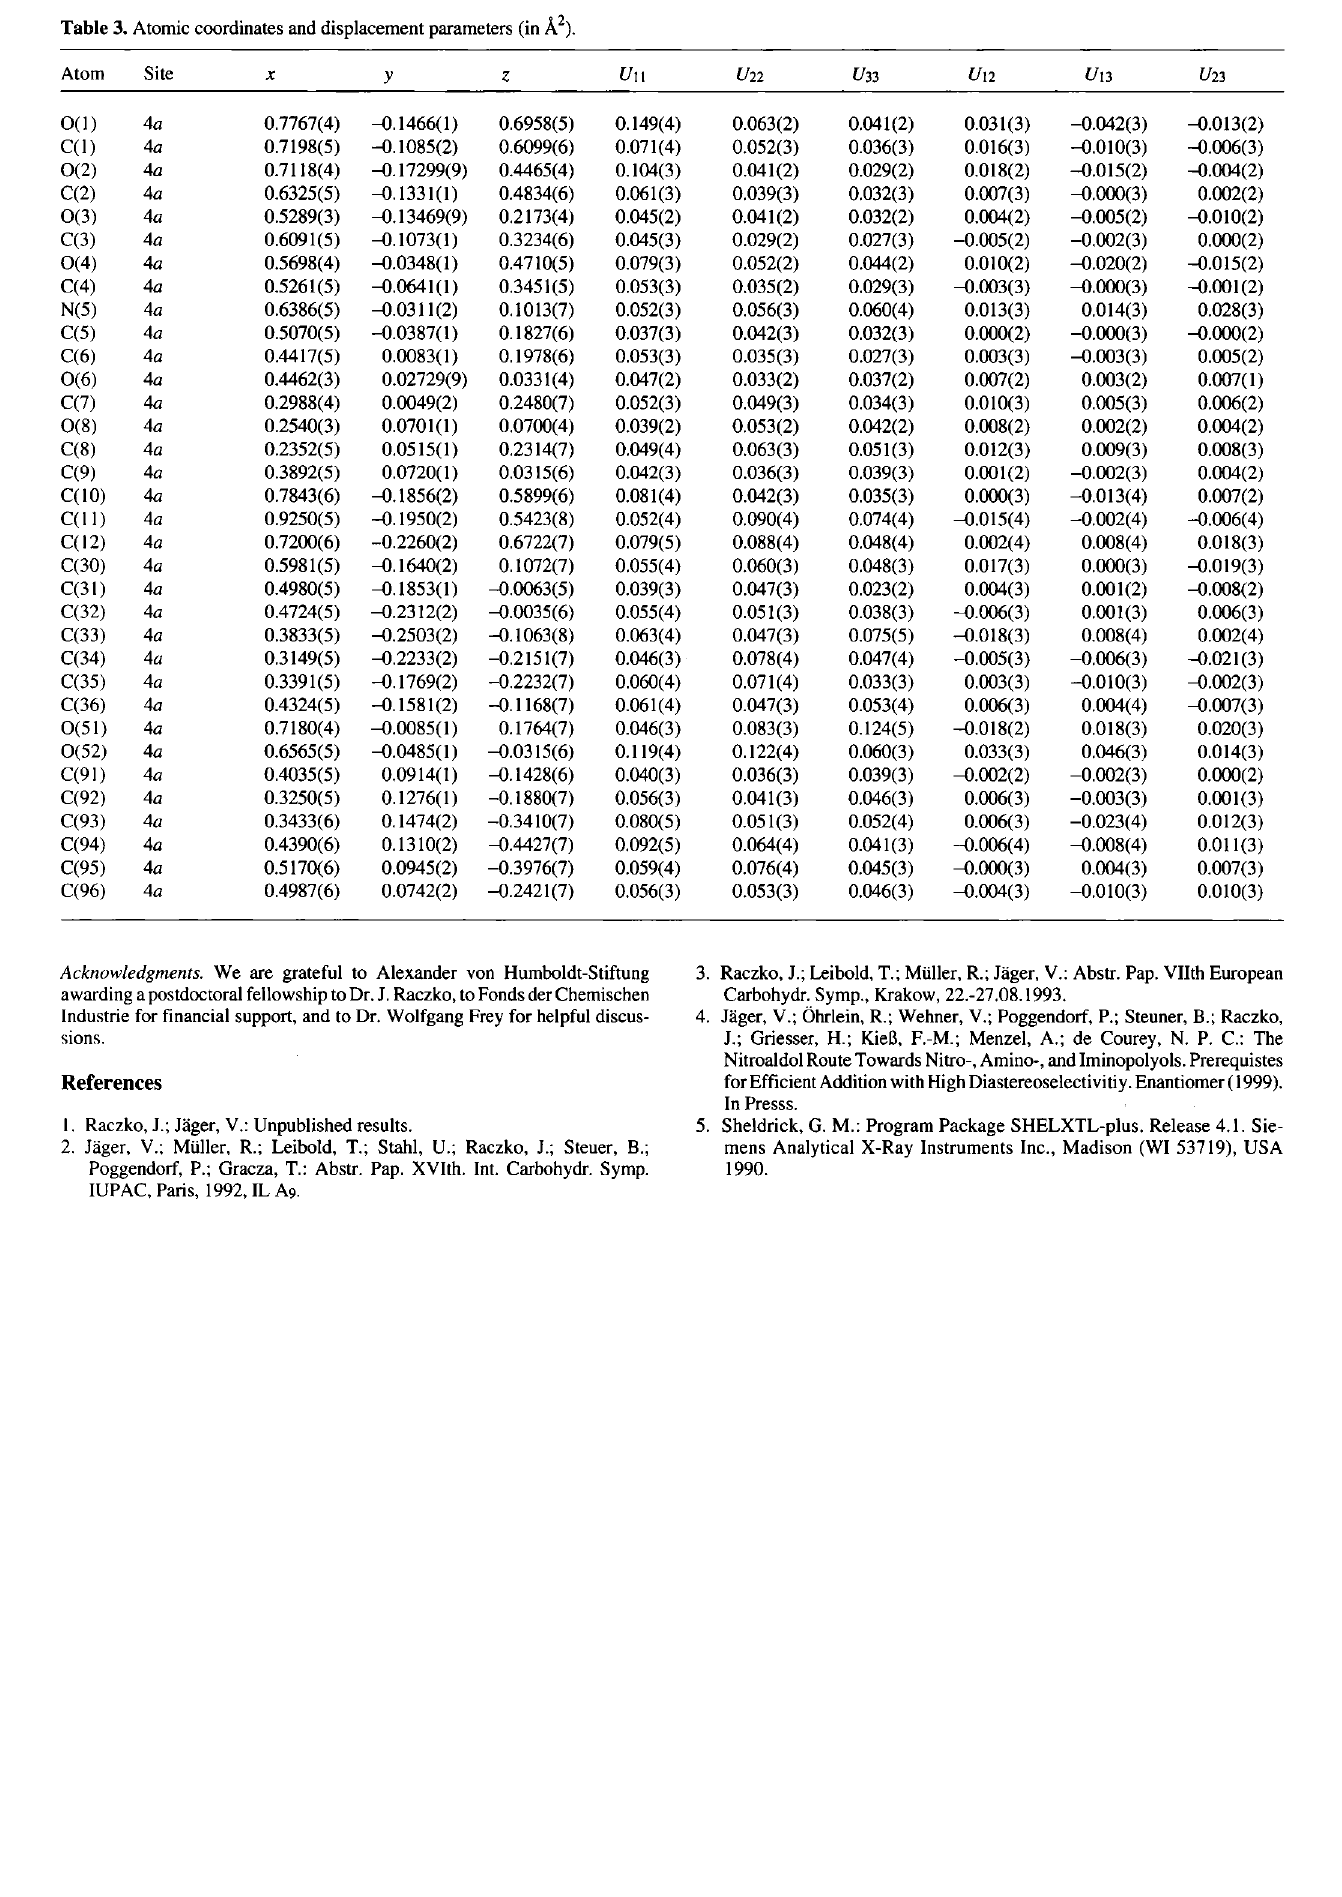
Table 3. Atomic coordinates and displacement parameters (in Ä 2